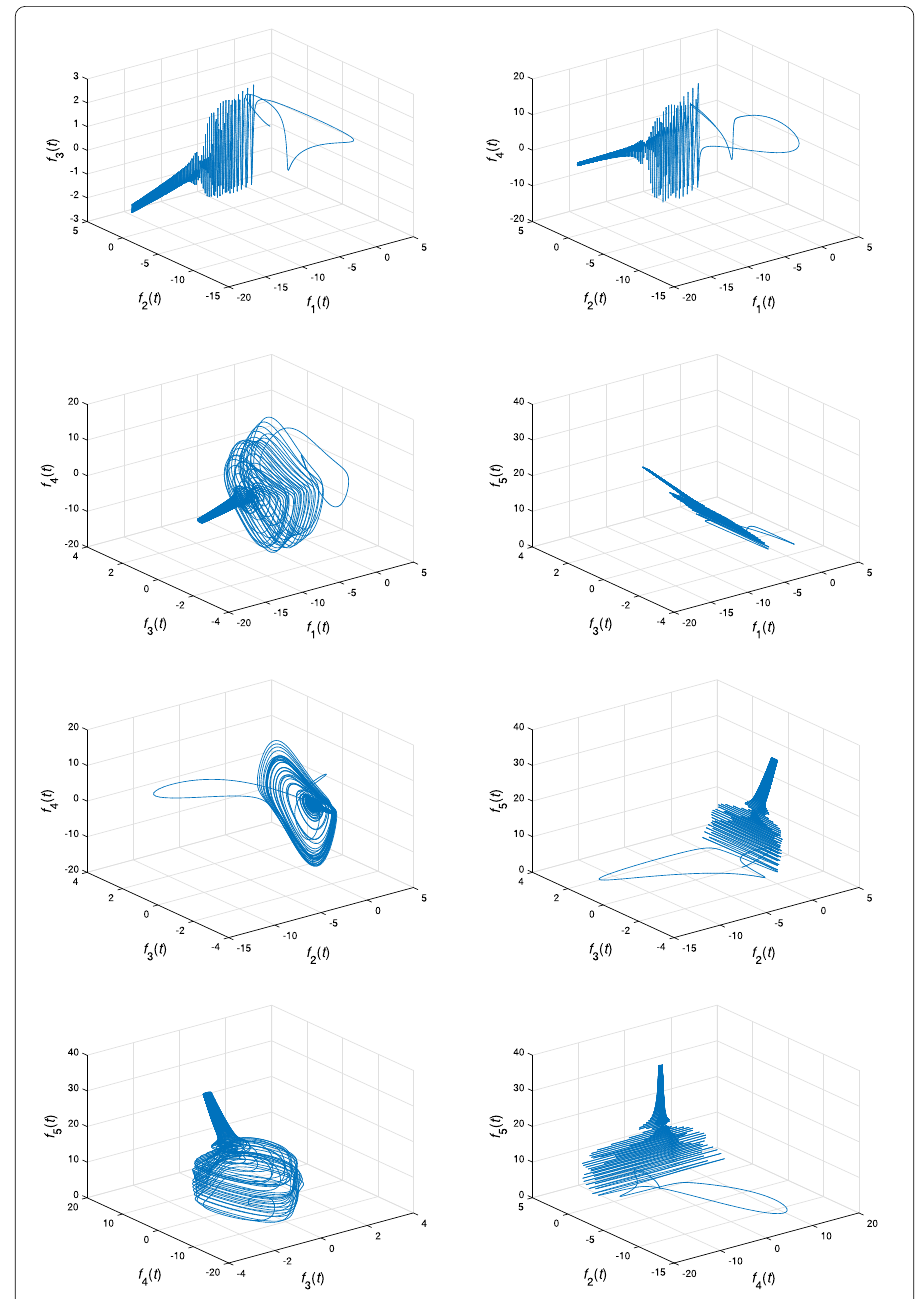
Figure 2 Three-dimensional phase planes of the integer cardiac conduction model